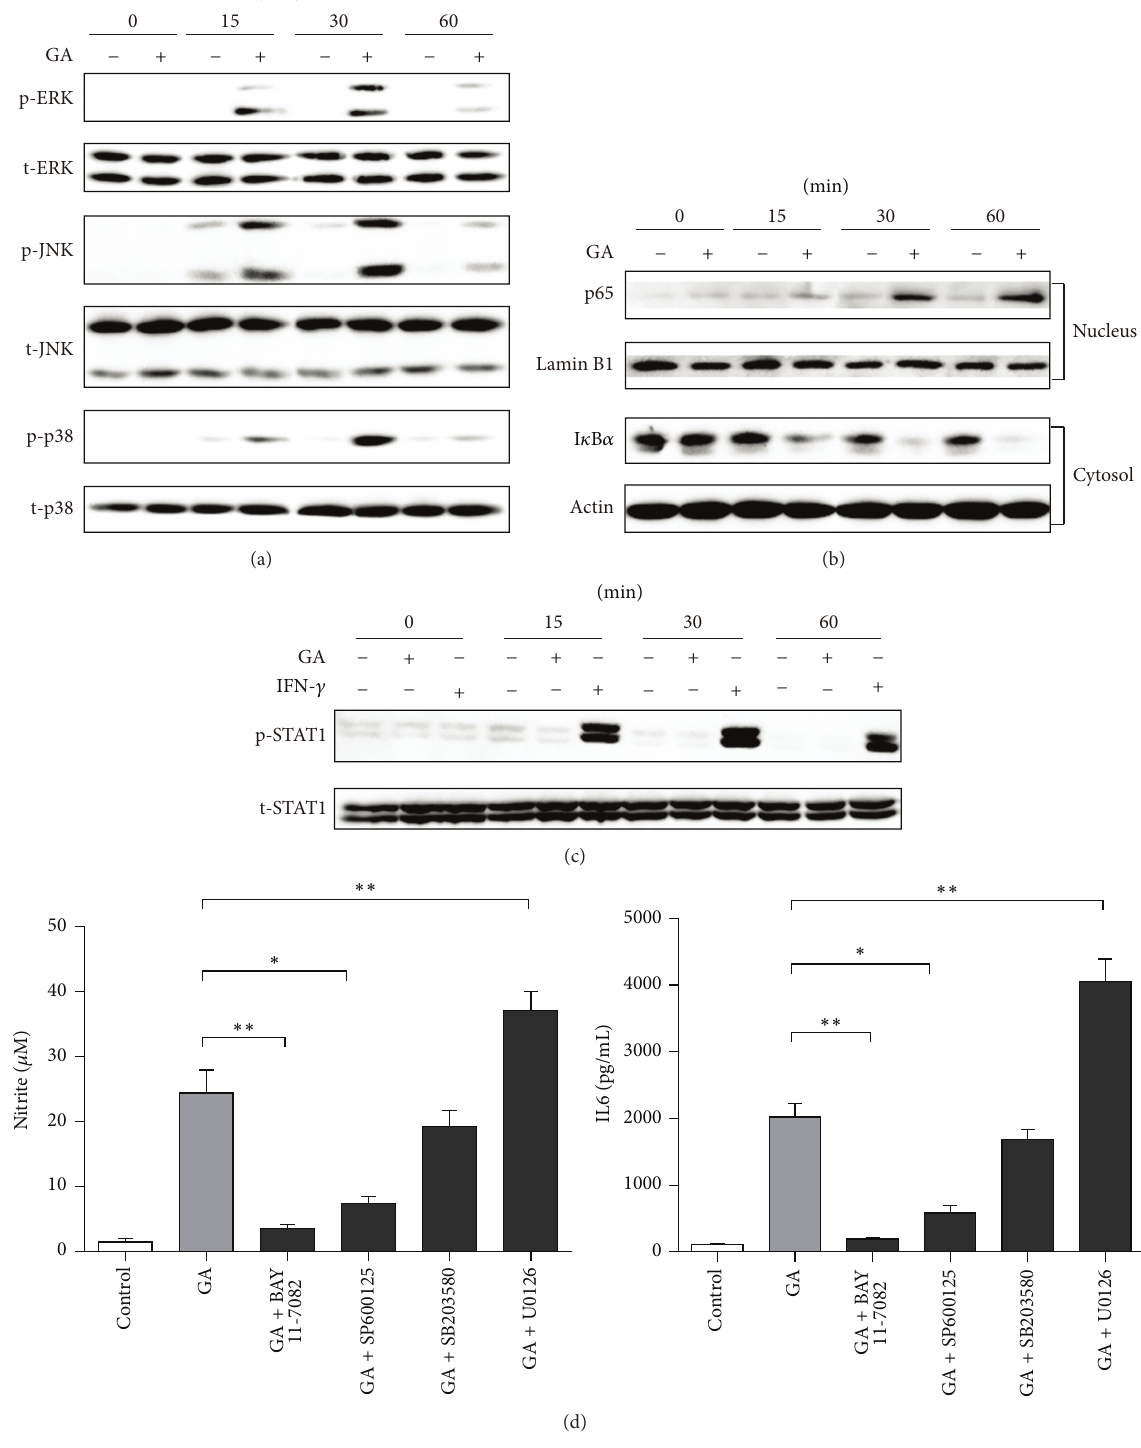
Figure 7: Effect of GA on MAPKs, NF- 𝜅 B, and STAT1 activation in BMDMs. BMDMs were treated with GA (100 𝜇 g/mL) or IFN- 𝛾 (100ng/mL) for the indicated time points. (a, c) Cell lysates were prepared, and phosphorylation of ERK1/2 (p-ERK1/2), JNK (p-JNK), p38 MAPK (p-p38), and STAT1 (p-STAT1) was analyzed by western blotting. (b) Nuclear and cytosolic extracts were prepared and subjected to western blotting with p65 and I 𝜅 B 𝛼 antibody, respectively. (d) BMDMs were pretreated with NF- 𝜅 B inhibitor (BAY 11-7082, 10 𝜇 M), JNK inhibitor (SP600125, 10 𝜇 M), p38 MAPK inhibitor (SB203580, 10 𝜇 M), or ERK1/2 inhibitor (U0126, 10 𝜇 M) followed by treatment with GA (100 𝜇 g/mL) for 48h, and then the production of nitrite and M1-related cytokines was analyzed. Data are mean ± SD for three independent experiments. ∗ 𝑃 < 0.05 , ∗∗ 𝑃 < 0.01 ( 𝑡